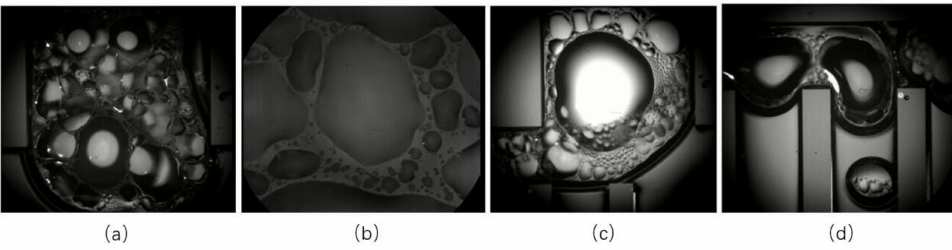
Figure 8. Microscopic images of the s-UTLHP at different stages of steady-state operation: ( a ) Image of the connection between the evaporator and the vapor phase line; ( b ) Image inside the evaporator; ( c , d ) The image of the inlet of the vapor phase pipeline during stable